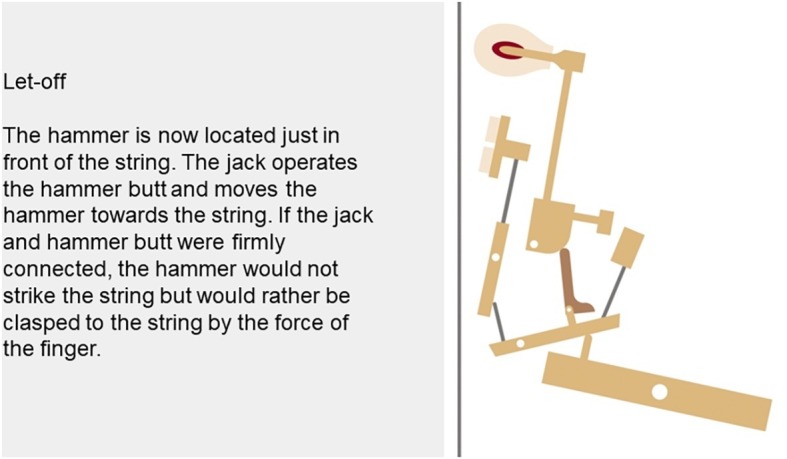
Screenshot from one page of the multimedia learning material (a German version was used in the experiment).